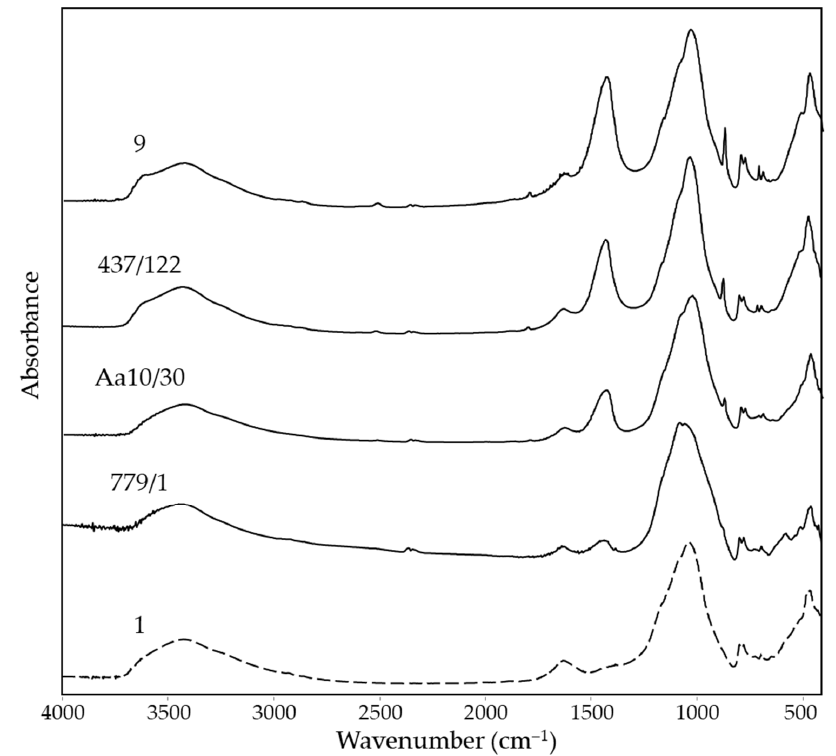
Figure 5. FTIR spectra acquired on KBr pellets of powders from some samples of bucchero from the excavation of La Civita di Tarquinia. The inventory numbers of the samples are indicated in the figure.